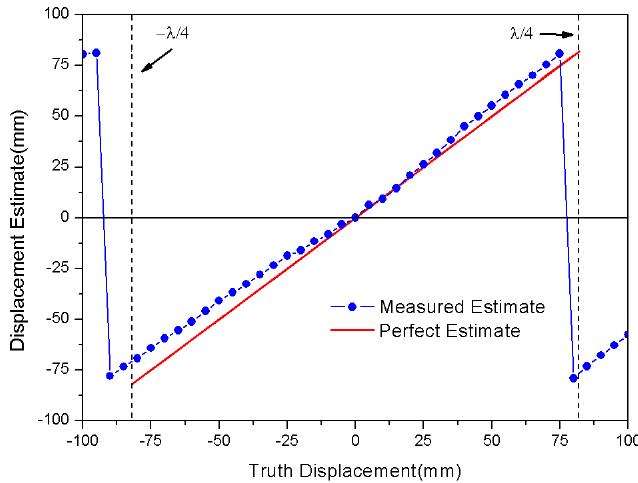
Figure 7. Comparison between measured and perfect estimated displacement.